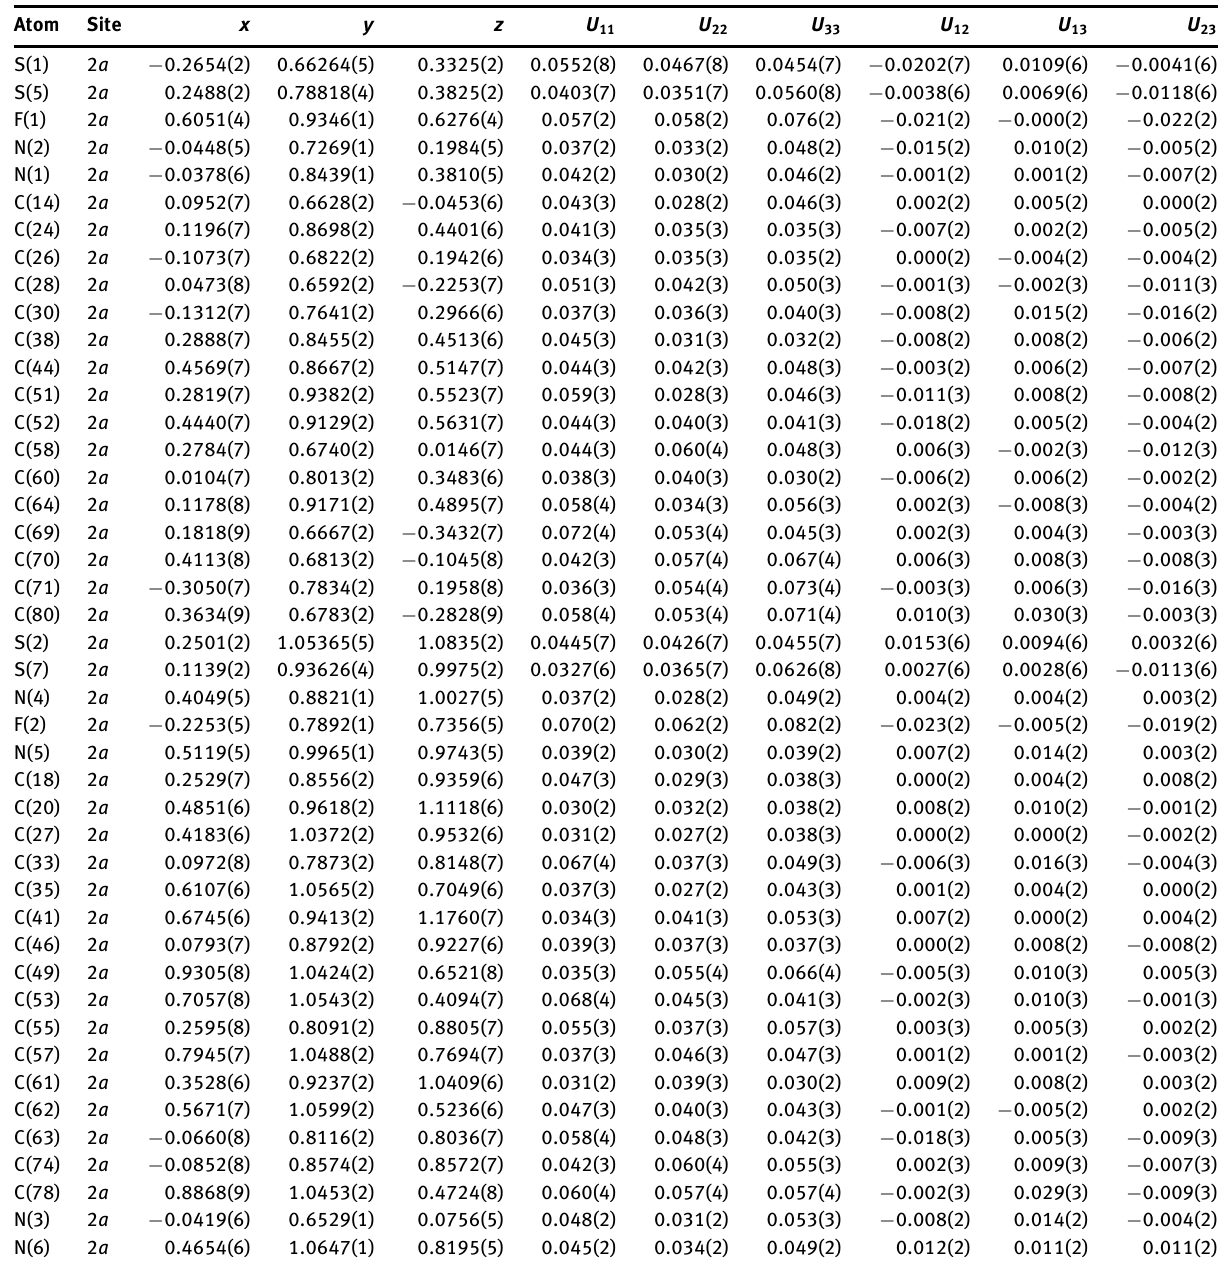
Table 3: Atomic displacement parameters (Å 2